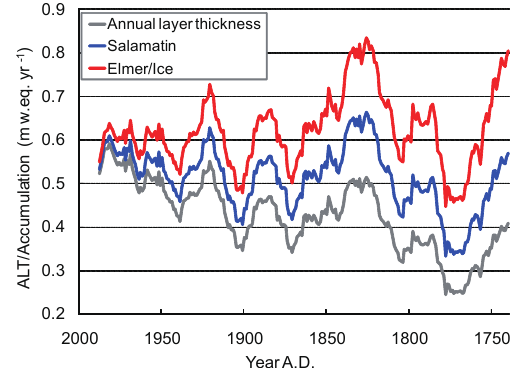
Fig. 6. Reconstructed 20yr mean accumulation rates and annual layer thickness (ALT)